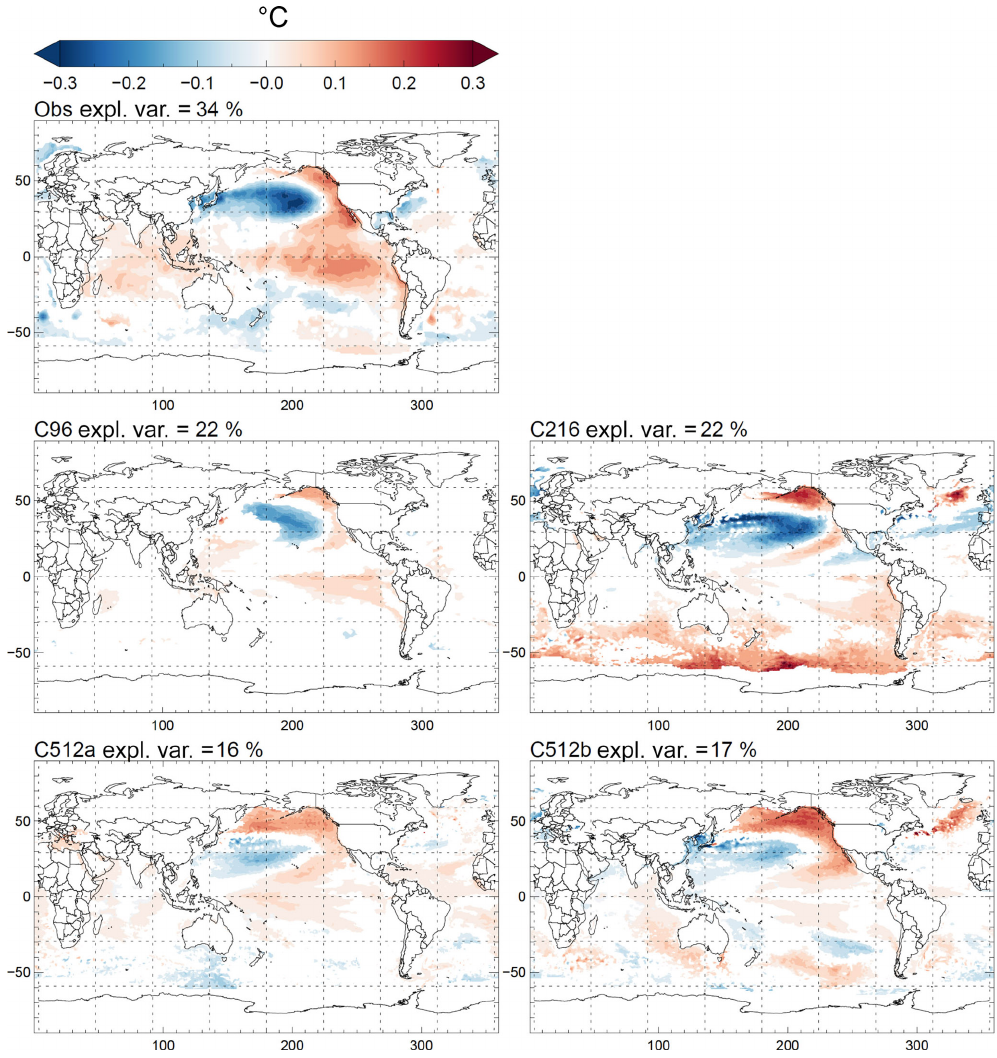
Figure 14. Regression against the PDO index of December–May mean detrended and low-pass-filtered ( > 10 years) SST anomalies for observations (1871–2010 HadISST) and the coupled simulations. All shown values exceed the 90% confidence level. The PDO index is the principal component of the leading EOF of December–May mean detrended SST anomalies north of 20 ◦ N in the North Pacific; the explained variance is shown above the panel. See Sect. 6 for more